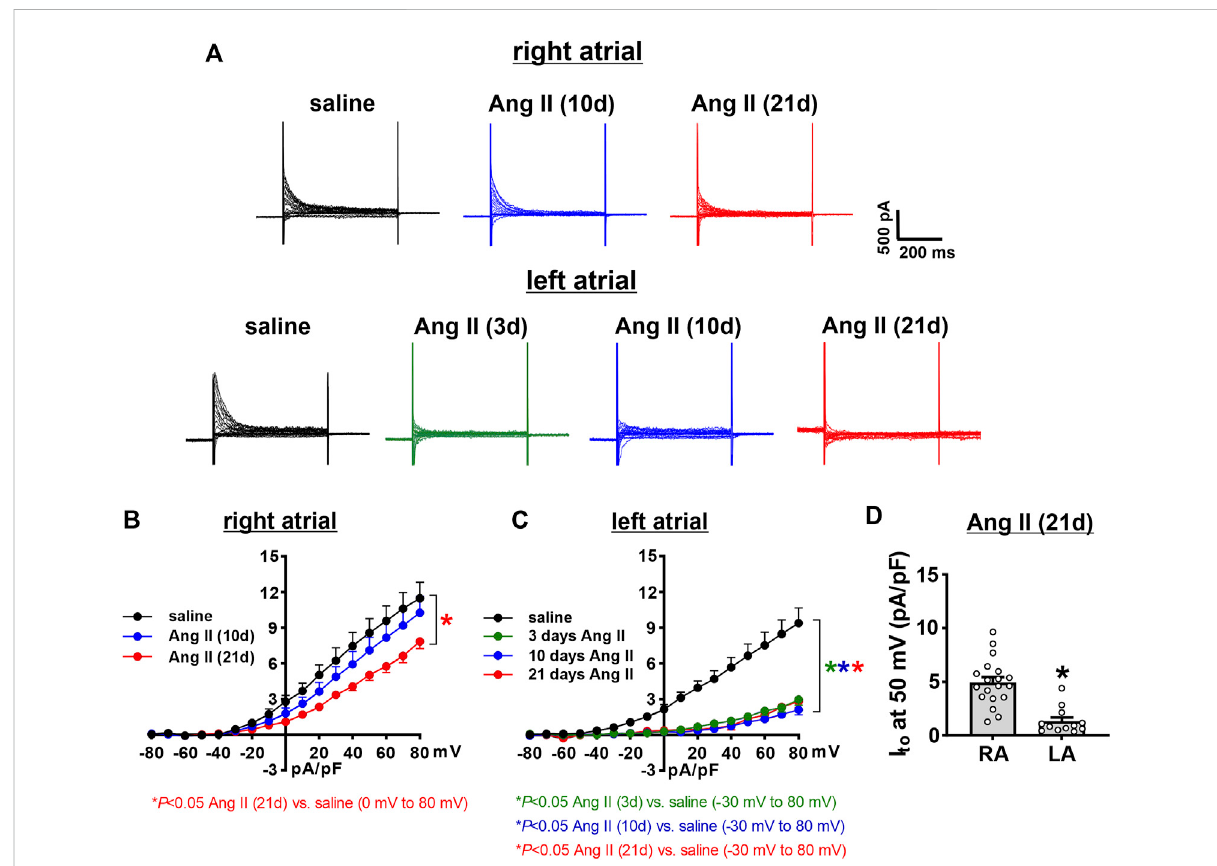
FIGURE 9 Time course of the effects of Ang II on the transient outward potassium current in right and left atrial myocytes. (A) Representative recordings showingthedifferencecurrentsfromI K recordingswithandwithoutapre-pulse(showninFigure 6,Figure7)inrightandleftatrialmyocytesisolated from mice infused with saline for 21 days or Ang II for 3, 10, and 21 days. These difference currents represent I to in each condition. (B) I to IV curves in rightatrialmyocytesisolatedfrommiceinfusedwithsalineorAngIIfor10and21 days. (C) I to IVcurvesinleftatrialmyocytesisolatedfrommice infusedwithsalineorAngIIfor3,10and21 days.* p < 0.05vssalineatindicatedmembranepotentialsbytwo-wayrepeatedmeasuresANOVAwitha Holm-Sidak posthoc test. For right atrial myocytes n =12 for saline, 14 for Ang II (10 days) and 21 for Ang II (21 days). For left atrial myocytes n =11 for saline, 15 for Ang II (3 days), 17 for Ang II (10 days) and 12 for Ang II (21 days). (D) Comparison of I to density at +50 mV in right atrial (RA) and left atrial (LA) myocytes after 21 days of Ang II infusion. * p < 0.05 vs RA by Student ’ s t -test; n =21 myocytes for RA and 12 myocytes for